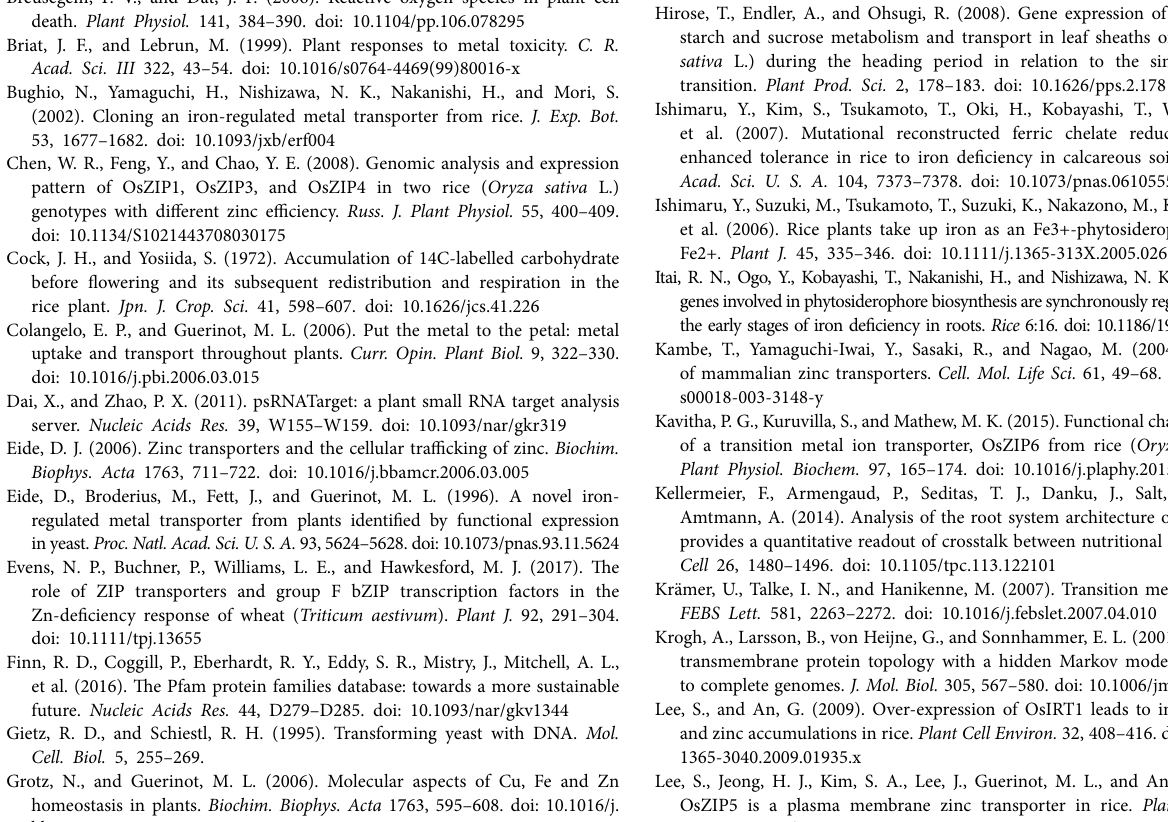
Supplementary Figure S1 | Phylogenetic relationship and homoeologs of the 58 TaZIP proteins. The gene that ends with S and L was identified by previous study. Genes highlighted in green were used for yeast complementation. Genes highlighted in yellow were used in this study by yeast complementation.